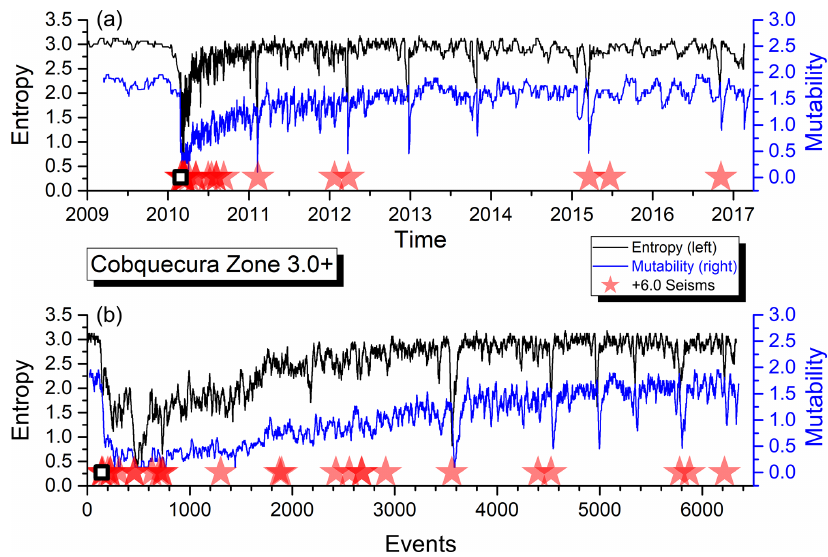
Figure 6. Shannon entropy and mutability as functions of real time (a) and natural time (or sequence of events, b ) for the seismic activity of zone D. The open star marks the position of the earthquake identified in Table